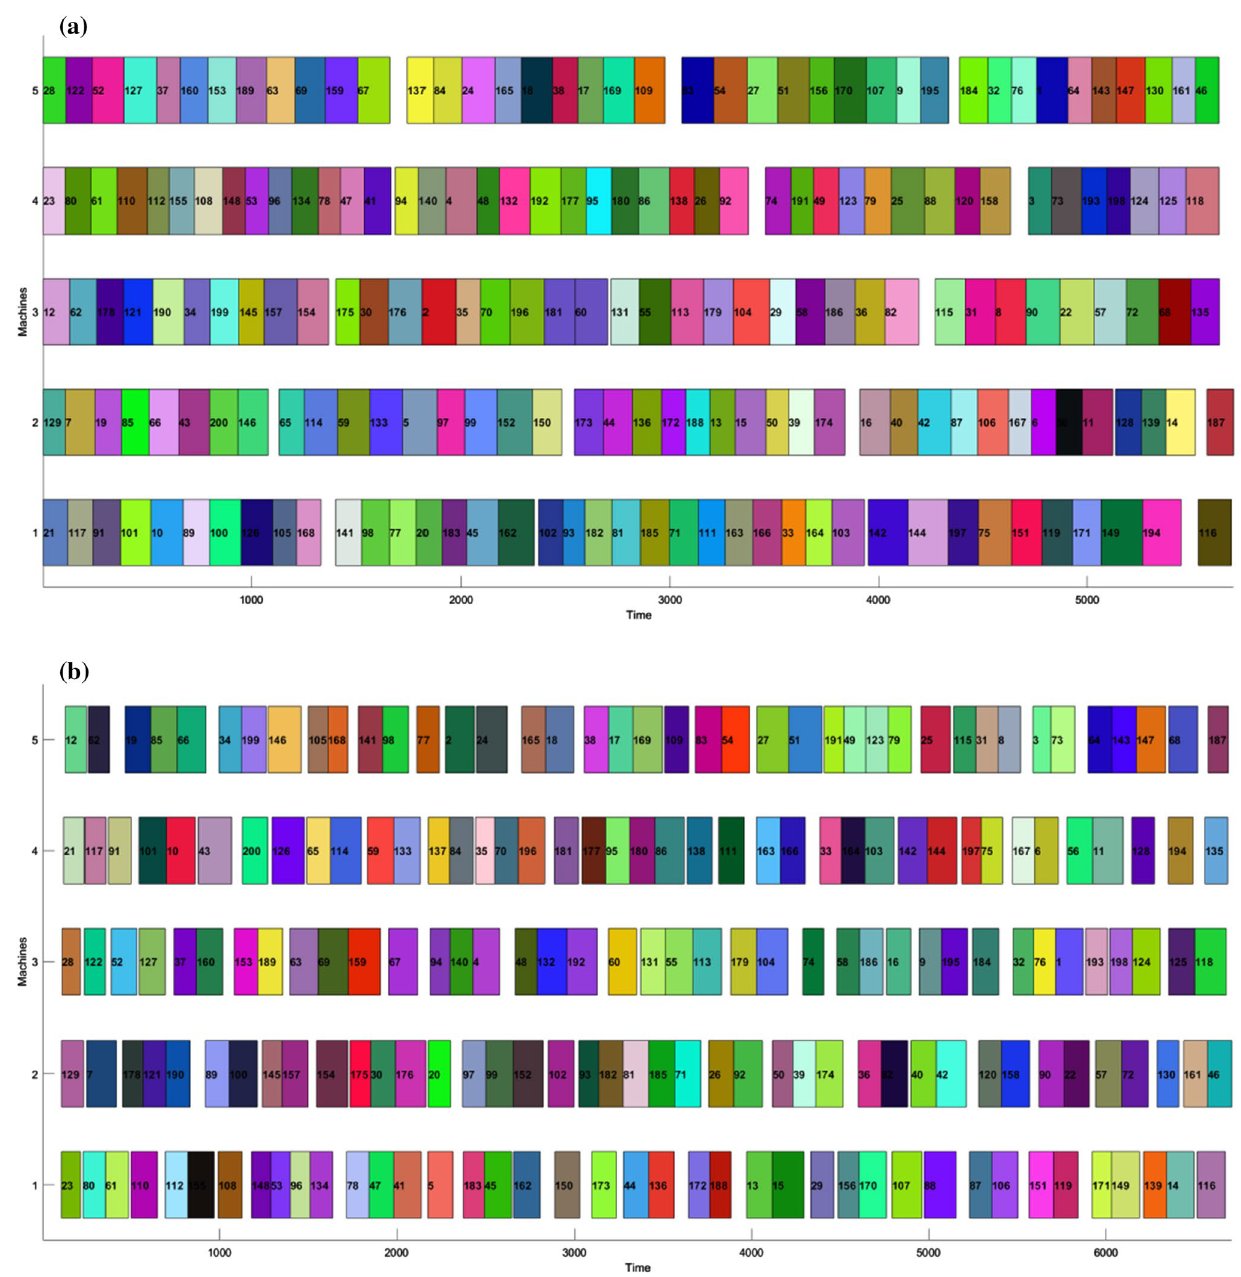
Fig. 10 The Gantt chart of the solution of NSGA-II-GTDSS. a , b correspond to the Gantt chart of the first stage and the second stage, respec-